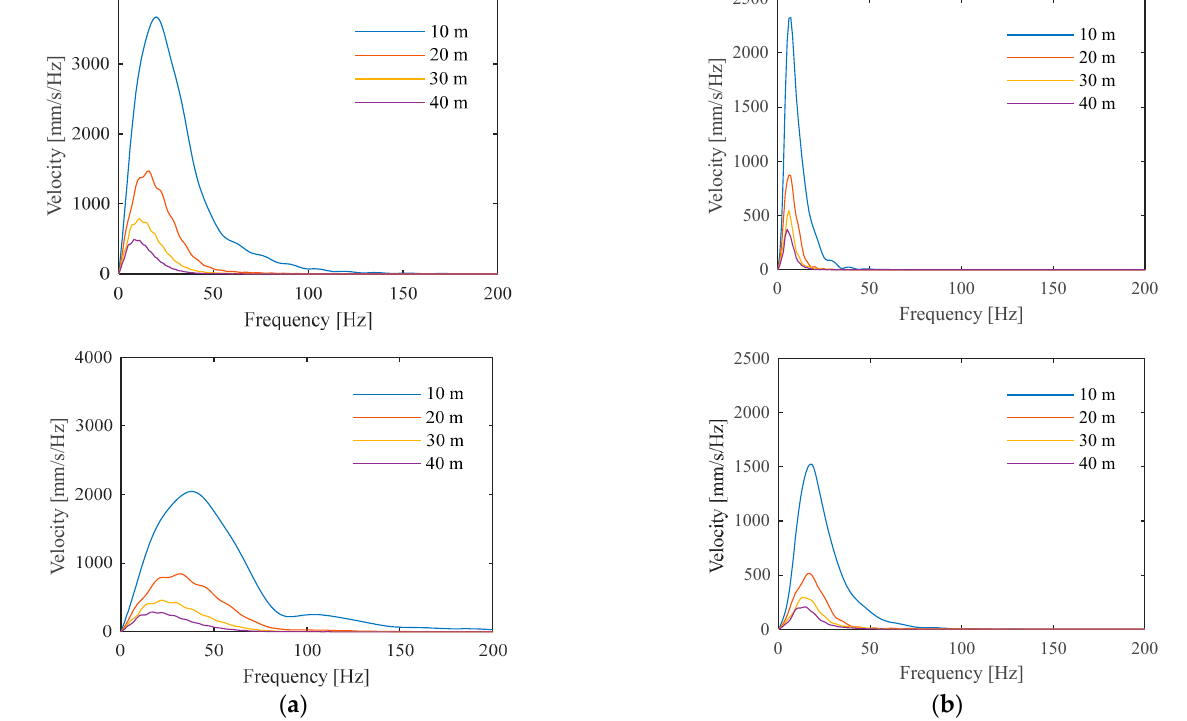
Figure 9. Vertical peak particle velocity record, in the frequency domain, for observation points at different distances from the source: ( a ) linear; ( b ) equivalent linear (upper: Vs = 80 m/s—Case 1; bottom: Vs = 160 m/s—Case 3).